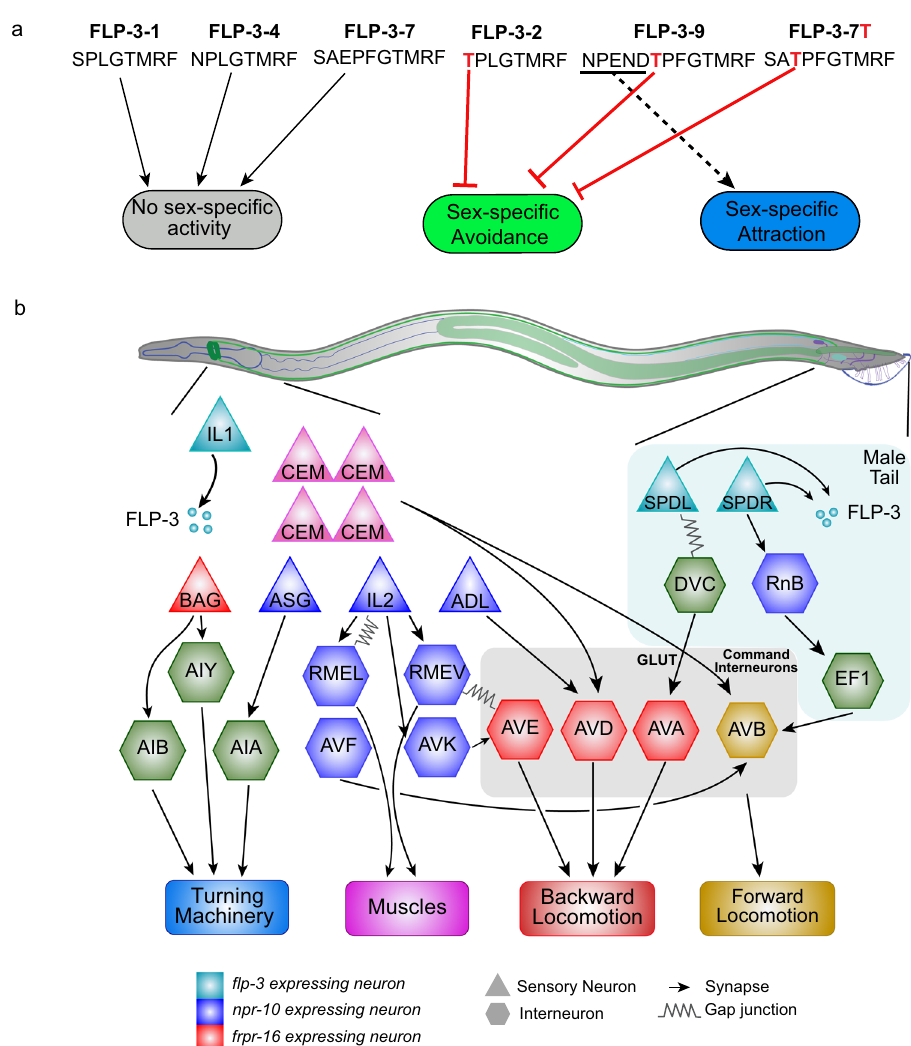
Fig. 7 Two FLP-3 NP/NPR modules mediate the male behavioral response to ascr#8. a Sequence speci fi city of FLP-3 peptide function. FLP-3-1, FLP-3-4, and FLP-3-7 exhibit no sex-speci fi c effects on ascr#8 behavioral response. The threonine in the 9th position of FLP-3-2 and FLP-3-9, and in the mutated FLP-3-7T (red) is required for suppressing the sex-speci fi c avoidance of ascr#8. The NPEND sequence of FLP-3-9 drives male attraction to ascr#8. b Schematic of the neural circuit regulating male responses to ascr#8 pheromone. ascr#8 is sensed by the male-speci fi c CEM neurons. The neuropeptide gene fl p-3 is expressed in the IL1 neurons in the head and the SPD spicule neurons in the tail (teal). Following release of processed FLP-3 peptides, FLP-3-2 and FLP-3-9 are sensed by NPR-10 and FRPR-16 expressing neurons (blue and red, respectively) to mediate dwelling in the mating pheromone by modulating forward and reverse locomotion. Green neurons are connections inferred from the male synaptic connectome 73 . Gold denotes the command interneuron AVB and the forward locomotory